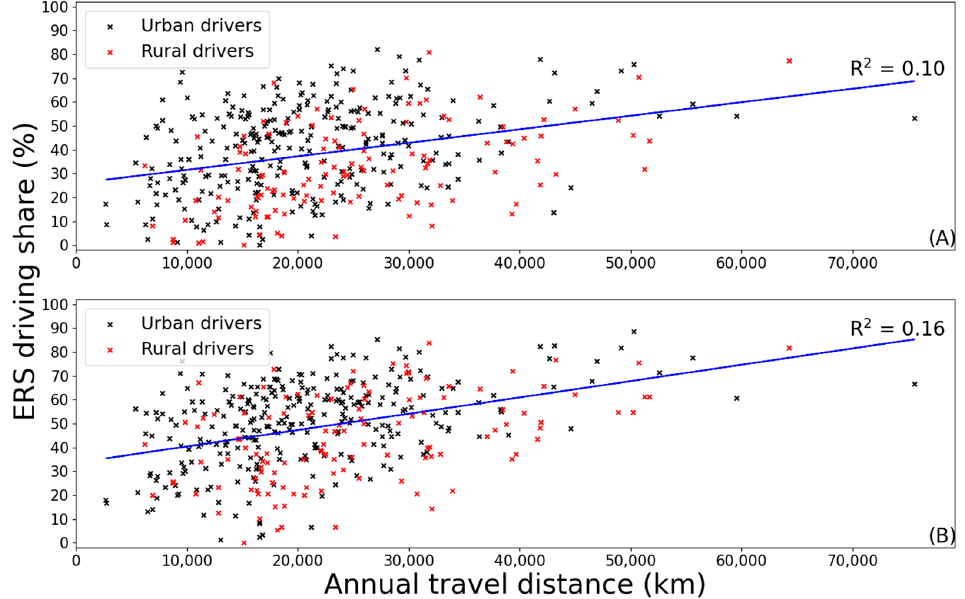
Figure 3. ERS driving shares for individual cars versus extrapolated annual travel distance for ( A ) E and N25 and ( B ) E and N100 for urban and rural drivers. Blue lines are the linear regressions for all drivers.